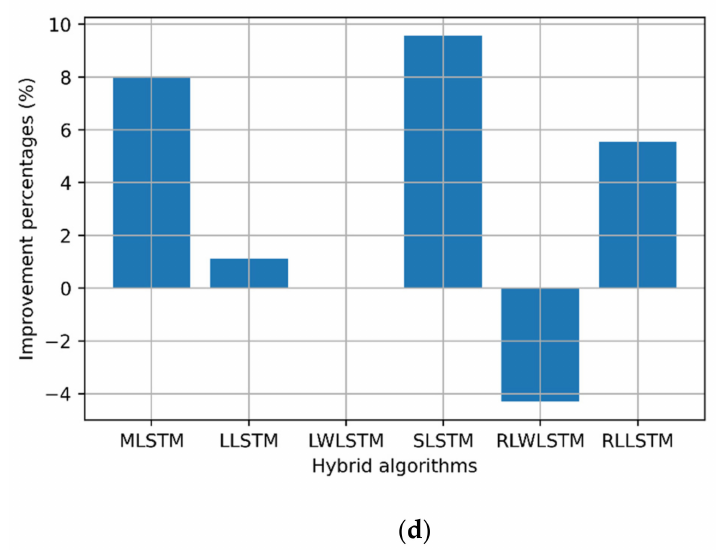
Figure 9. Improvement percentages for upstream: ( a ) training RMSE, ( b ) training time, ( c ) 350 time steps’ testing, and ( d ) 350 time steps’ testing